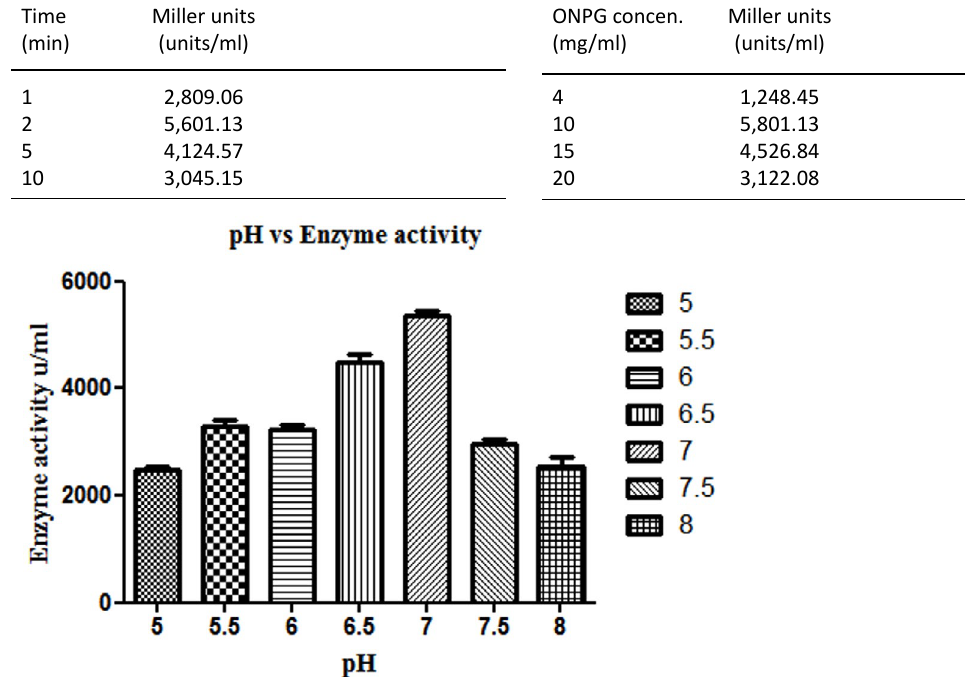
Fig. 1. Effect of different pH on β-gal production by L. fermentum . Bars show standard deviations with significant difference